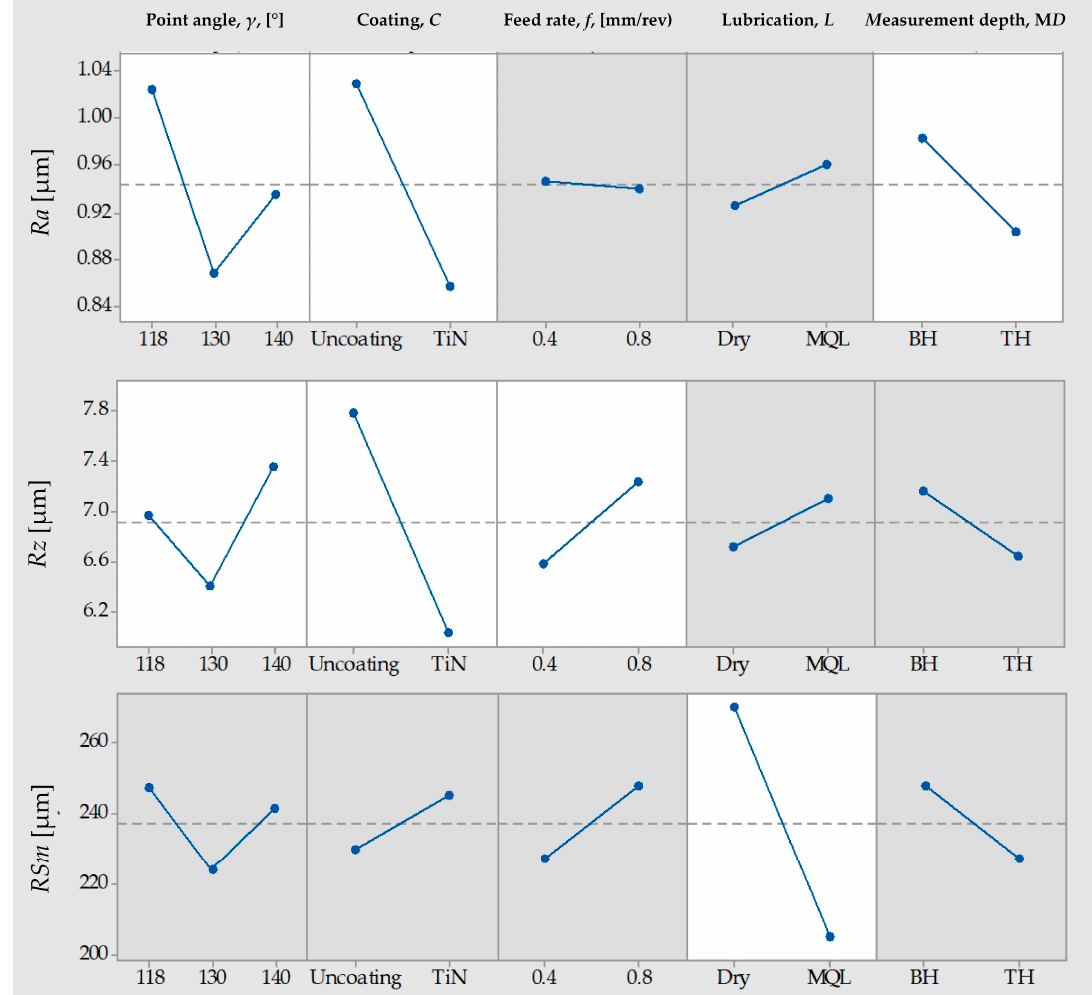
Figure 6. Main effects for Ra , Rz and RSm . White background represents a term in the model. Figure 6. Main e ff ects for Ra , Rz and RSm . White background represents a term in the